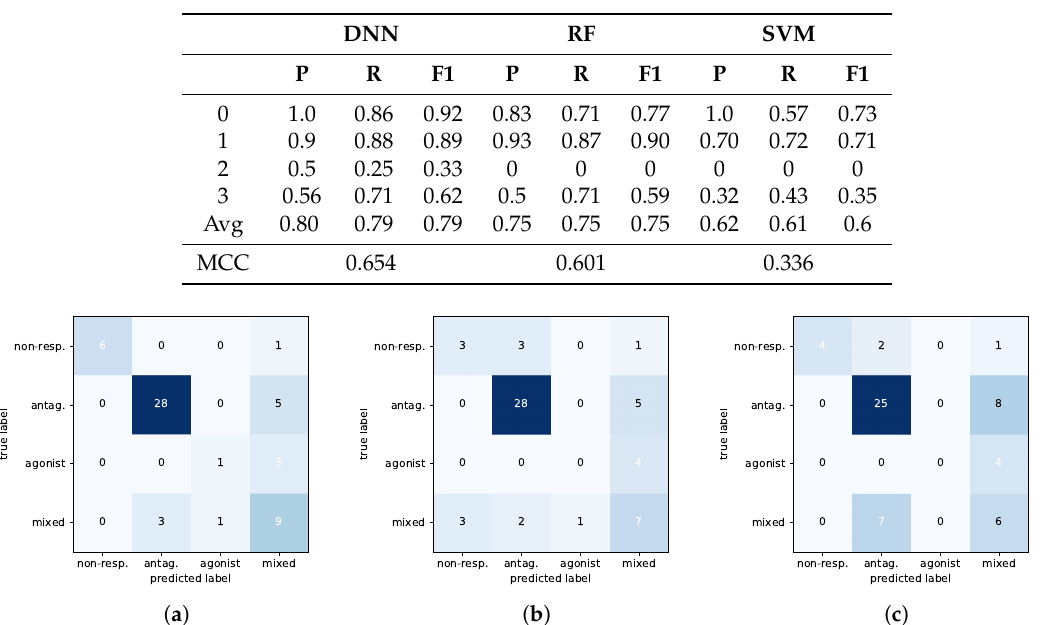
non-resp. antag. agonist mixed predicted label ( b )